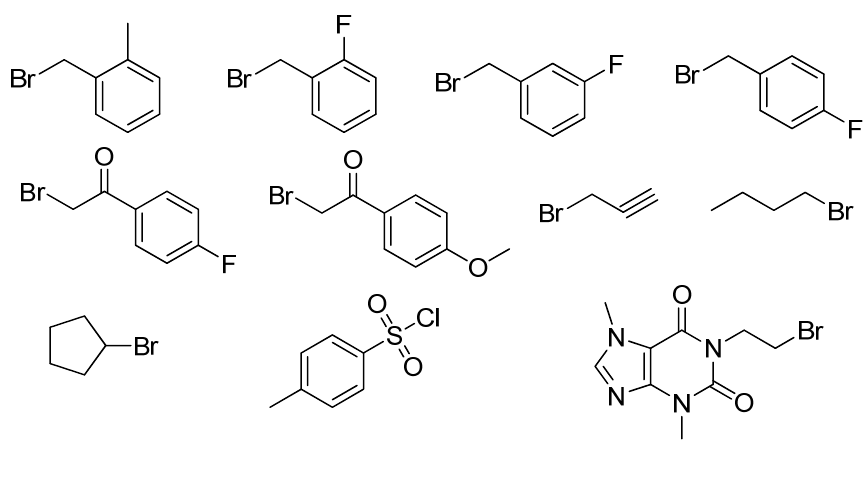
Figure 5. The chemical structure of reagents R 2